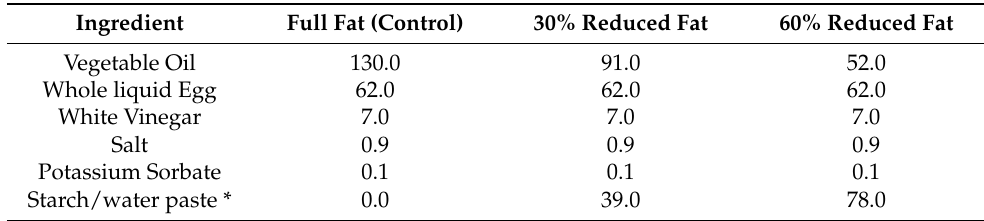
Table 1. Composition of oil-in-water emulsions based on the weight of the ingredients used in grams. Composition are based on 200 g of total emulsion